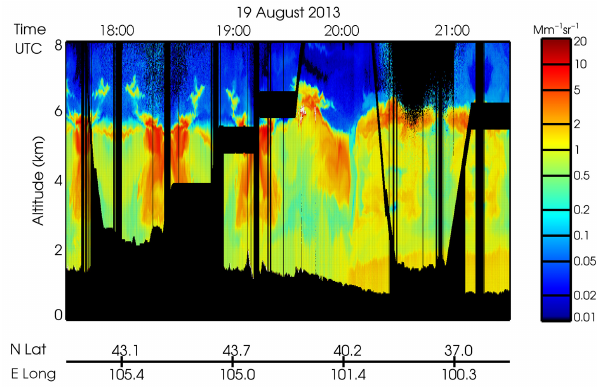
Figure 1. Composite of DIAL/HSRL-2 vertical profiles of the aerosol backscatter coefficient at 532µm as sampled on the research flight on 19 August 2013.